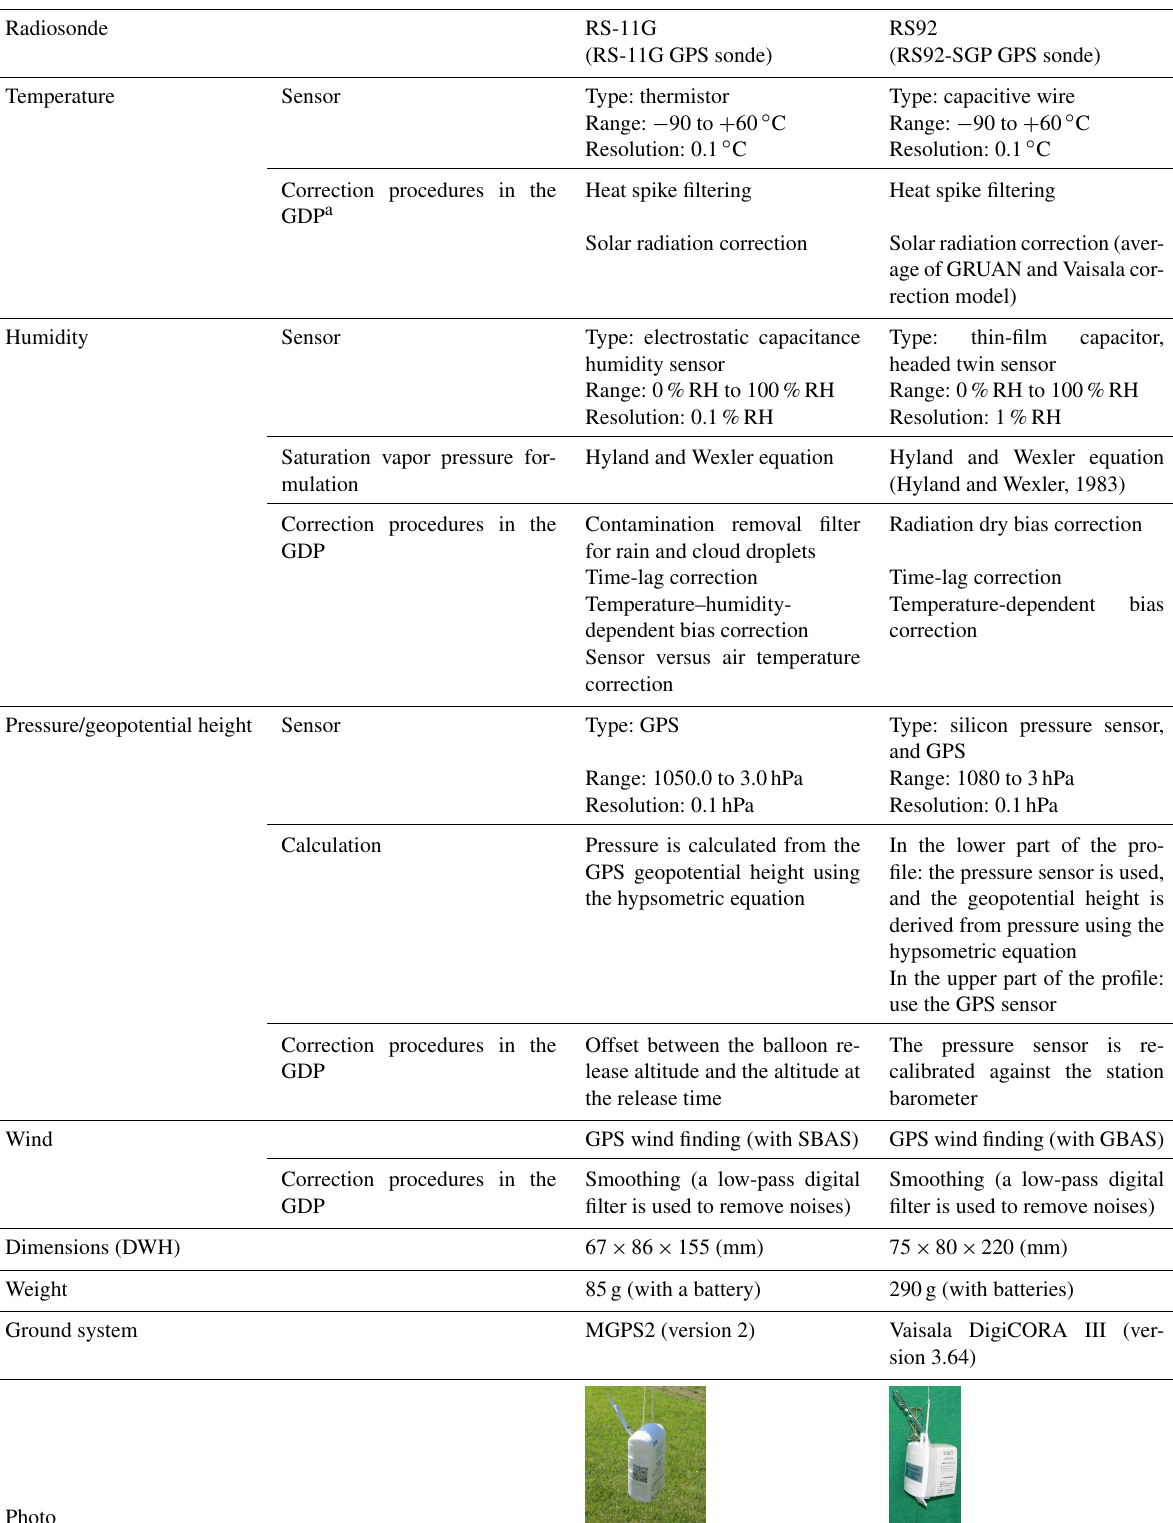
Table 1. Specifications of radiosondes and GRUAN data products (Meisei Electric Co., Ltd., 2016; Vaisala Oyj, 2013; Dirksen et al., 2014; Kizu et al.,